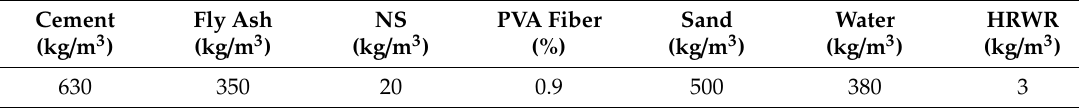
Table 5. Mix proportion of the cementitious